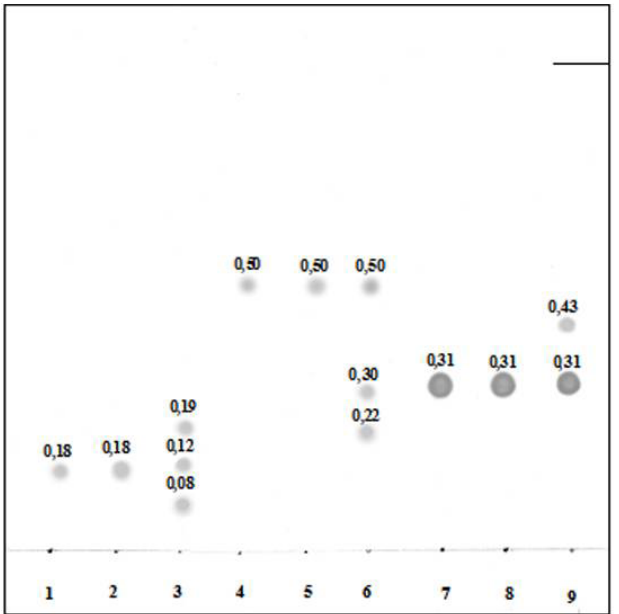
Fig 1 . Thin-layer chromatogram of 1: fumarprotocetraric acid (FUM) standard (R 0.18); 2: purified FUM (R 0.18); 3: acetone extract of f f Cladonia verticillaris (R 0.12); 4: usnic acid (USN) standard (R 0.50); f f 5: purified USN (R 0.50); 6: ether extract of Cladonia substellata (R f f 0.50); 7: barbatic acid (BAR) standard (R 0.31); 8: purified BAR (R f f 0.31); 9: ether extract of Cladia aggregata (R 0.31). f